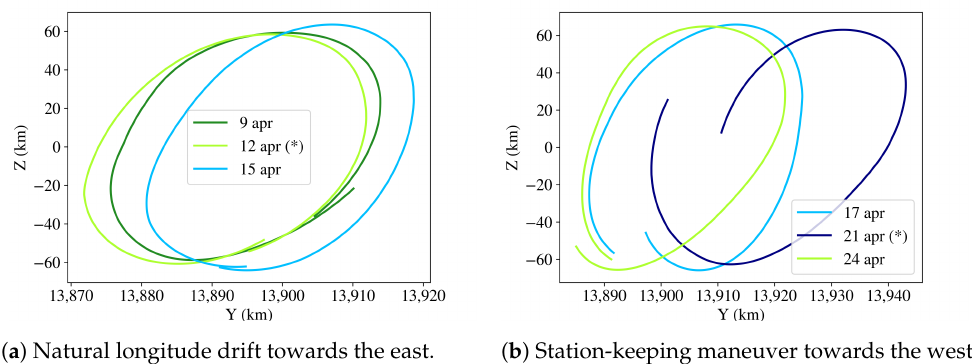
Figure 8. Resulting trajectory of the Astra 1M satellite represented in the Earth-Centered Earth-Fixed (ECEF) coordinate system. Each figure represents three orbit arcs of 25 h each along the interferometric observation period. The Y axis points to eastern longitudes and * indicates an orbital maneuver. ( a ) The satellite slows down its movement towards the west from 9 to 12 April, when it starts naturally drifting towards the east. ( b ) The satellite keeps drifting towards the east from 17 to 21 April, when a station-keeping maneuver is performed, causing it to start moving towards the